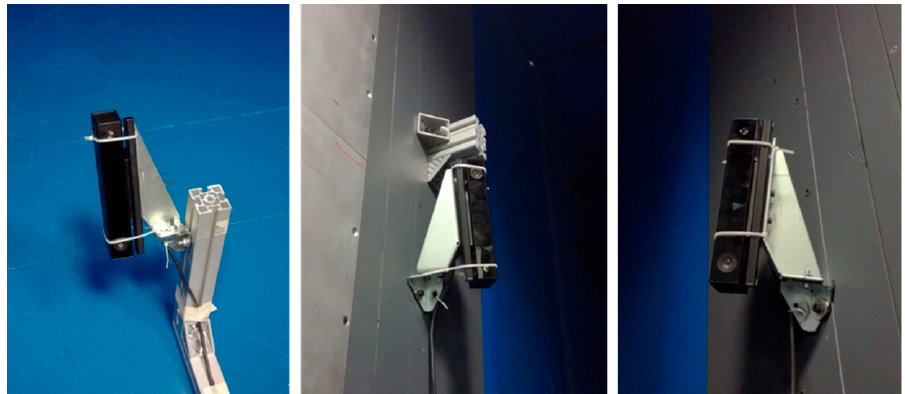
Figure 4. Pictures of the Kinect V2 1, 2, and 3, respectively, for wind tunnel test (cable ties to fix the sensors do not affect the point cloud acquisition).